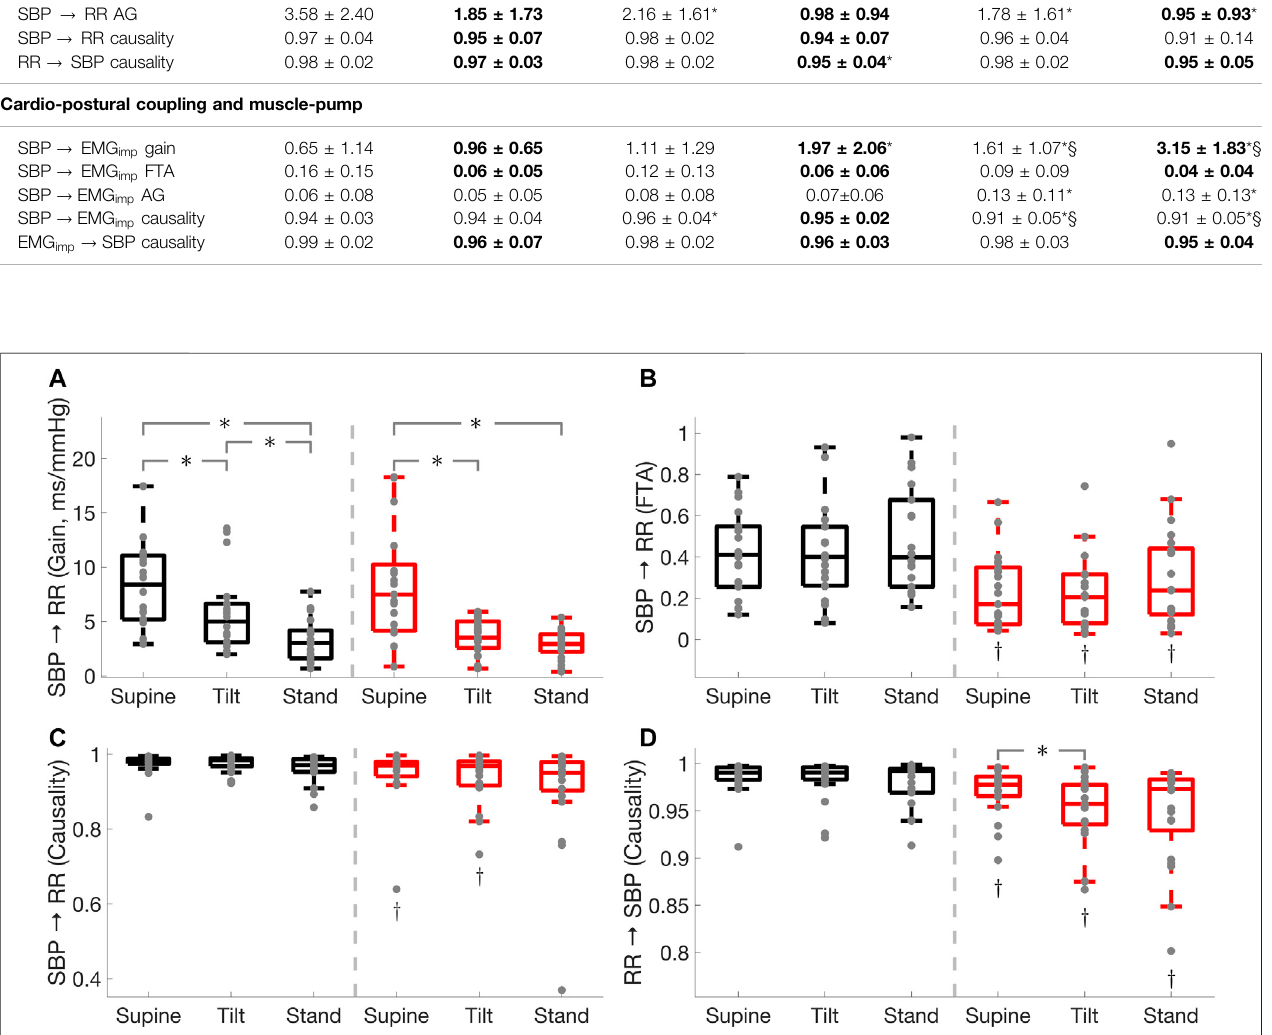
FIGURE 1 | Comparison of cardiac barore fl ex ( SBP → RR ) and the effect of heart rate on blood pressure (RR → SBP) in Parkinson ’ s disease patients (red) and healthycontrols(black)duringsupine,tiltandstandingpositions.Barore fl exgain (A) ,fractiontimeactive (B) ,causality (C) ,andthemechanicaleffectoftheheartonblood pressure (D) . * illustrates a signi fi cance difference for multiple comparison (post-hoc analysis with Bonferroni adjustment) between supine, tilt, and standing in Parkinson ’ s disease patients and healthy controls, while † represents a signi fi cant difference (Wilcoxon rank sum test) between Parkinson ’ s disease patients and healthy